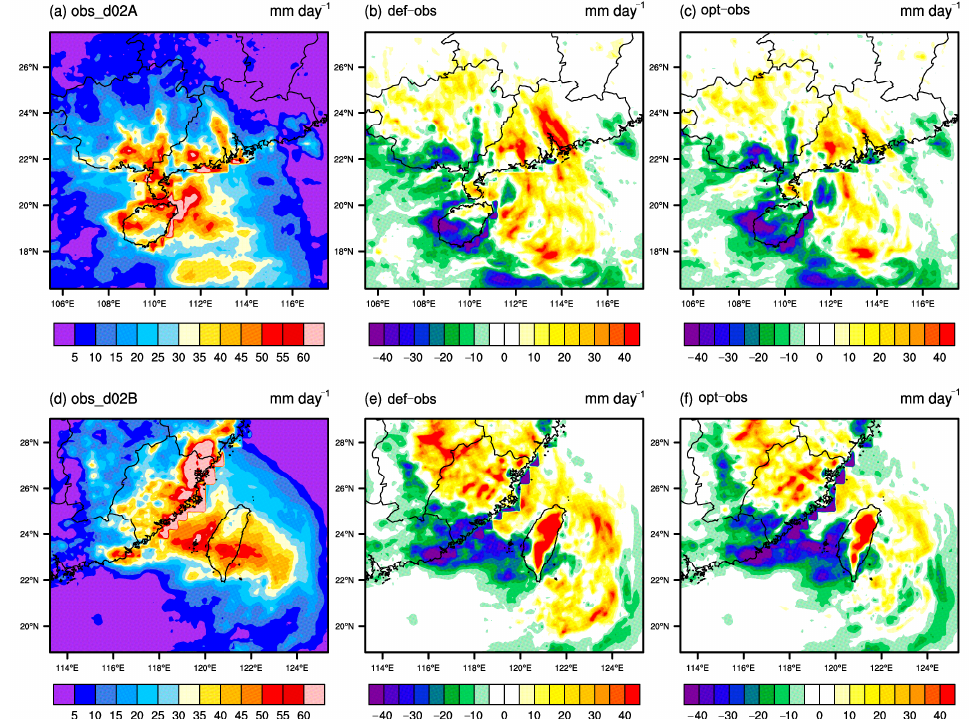
Figure 7. Comparisons of the spatial distribution of 3-day precipitation simulations using the WRF model with default and optimal parameters. ( a ) observed precipitation in d02A; ( b ) precipitation bias in d02A between default and observation; ( c ) precipitation bias in d02A between optimization and observation; ( d ) observed precipitation in d02B; ( e ) precipitation bias in d02B between default and observation; ( f ) precipitation bias in d02B between optimization and observation.